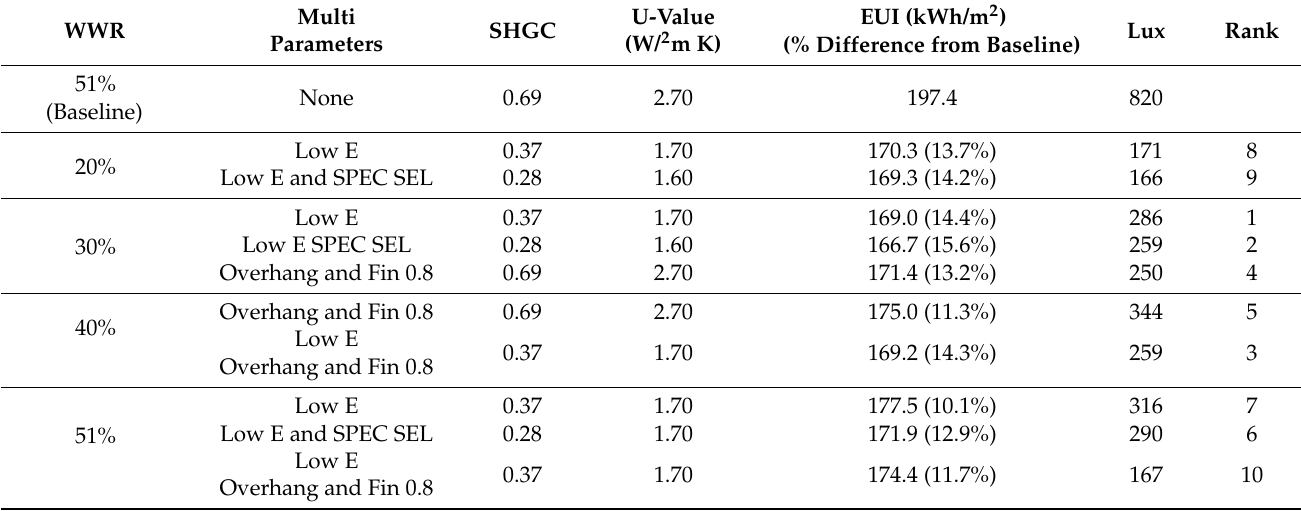
Table 8. The effect of multiparameters on EUL and lux of the west façade.